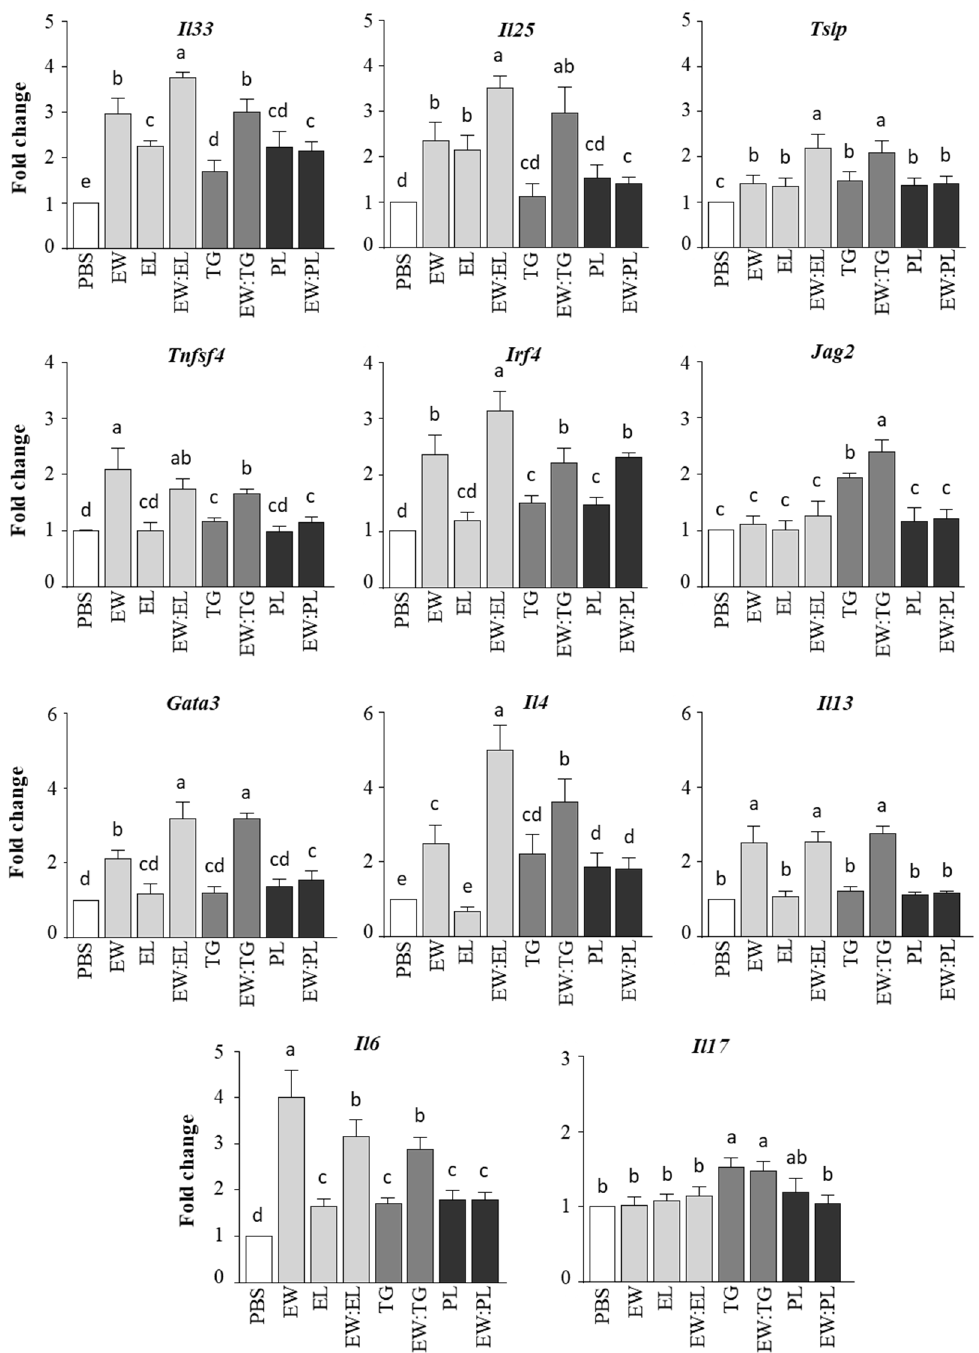
Figure 3. Relative gene expression of Il33, Il25, Tslp , Tnfsf4, Irf4, Jag2, Gata3, Il4, Il13, Il6 , and Il17 , determined in the duodenum of mice intragastrically administered PBS, egg white (EW, 50 mg), egg lipids (EL, 60 mg), a triacylglyceride-enriched fraction (60 mg, TG), a phospholipid-enriched fraction (60 mg, PL), and their mixtures (50 mg:60 mg) with EW (respectively EW:EL, EW:TG, EW:PL) for 6 consecutive days. Gene expression was normalized to the reference gene Actb and compared with mice administered PBS. Data are expressed as means ± SEM ( n = 6). Different letters indicate statistically significant differences ( p < 0.05) among different mouse groups.